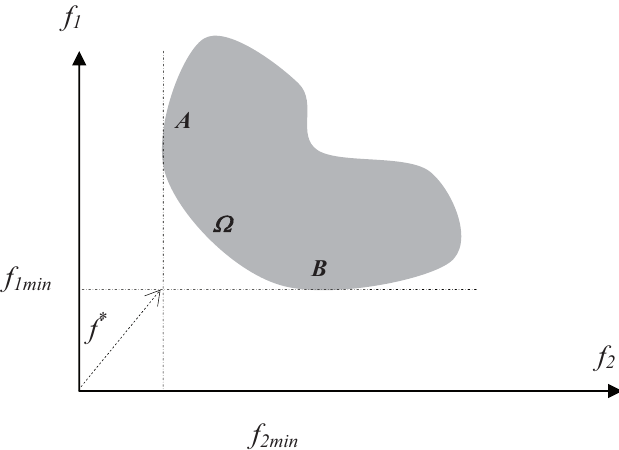
Fig. 2. Pareto curve (Min (f 1 and f 2